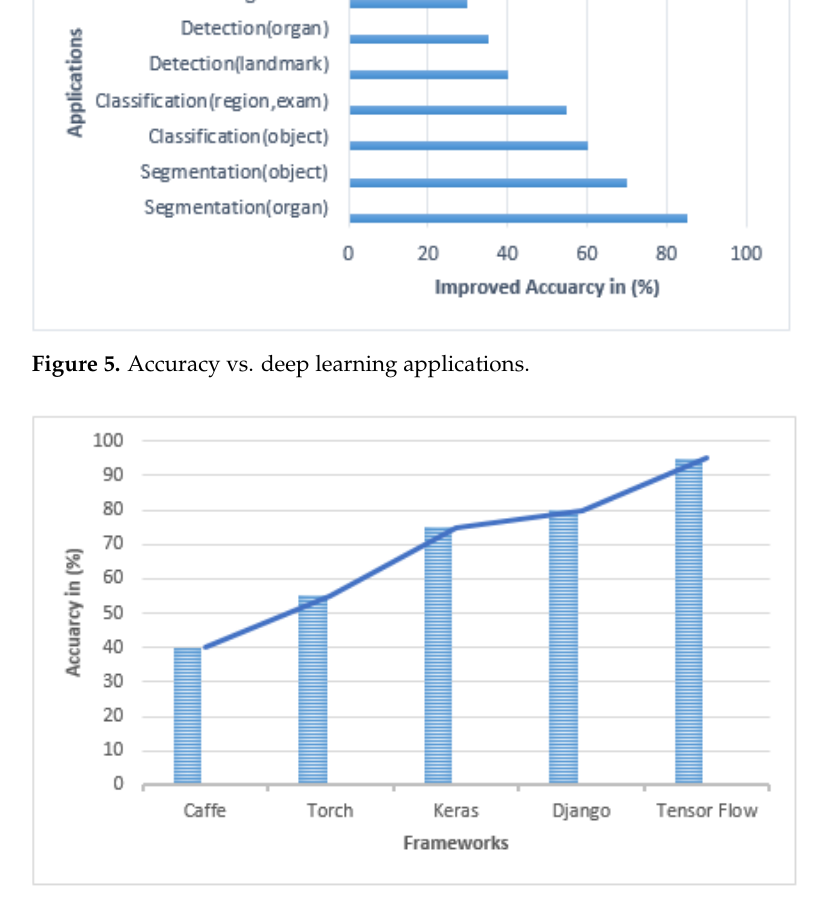
Figure 6. Accuracy vs. deep learning